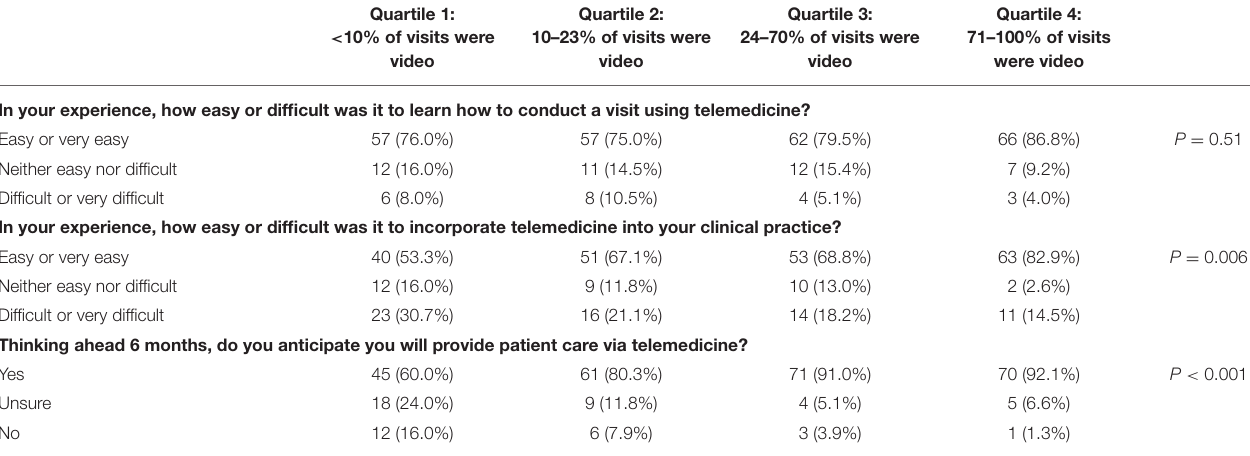
TABLE 2 | Attitudes toward telemedicine relative to percent of visits conducted by video in a typical week in